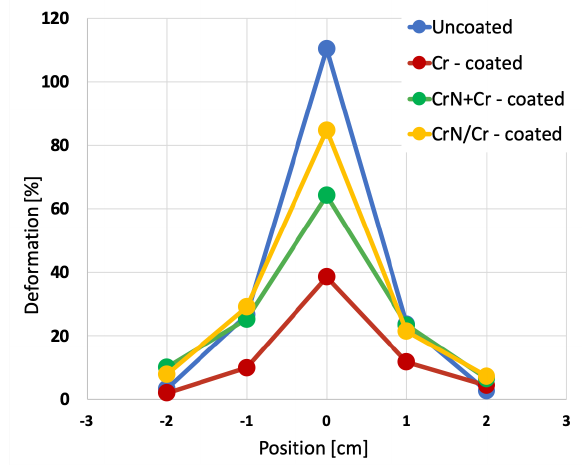
Figure 7. Deformation at temperature 800 ◦ C under inner pressure of 6 MPa in relation to position for different types of coatings and uncoated